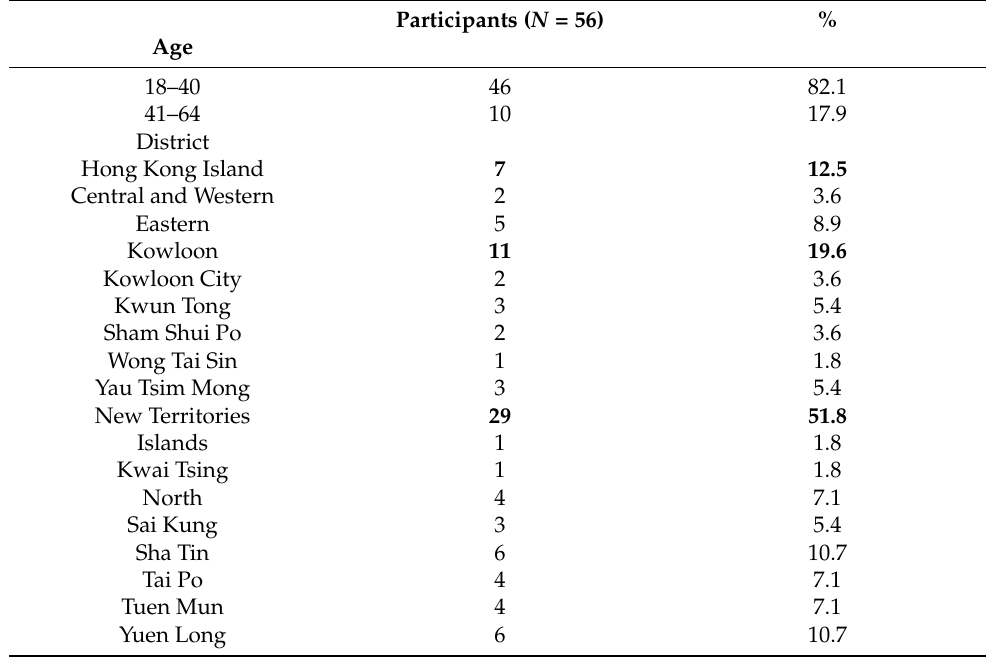
Table A3. Participant Characteristics of Volunteers and Members of the